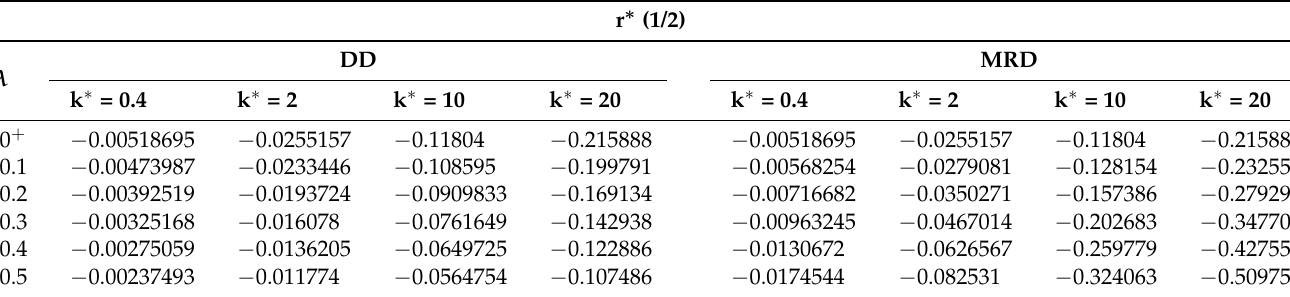
Table 7. Simply supported beam subjected to a non-dimensional uniform load q ∗ y = − 1. Non-dimensional midpoint foundation reaction r ∗ ( 1/2 ) versus the non-dimensional length-scale parameter λ evaluated by the non-dimensional Winkler parameter k ∗ ∈ { 0.4,2,10,20 } in the DD and MRD models.